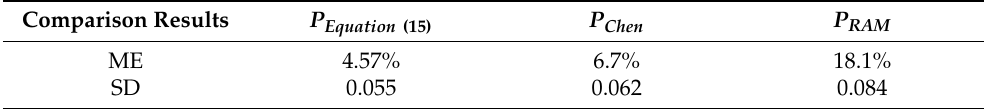
Table 3. Comparison with experimental data and other